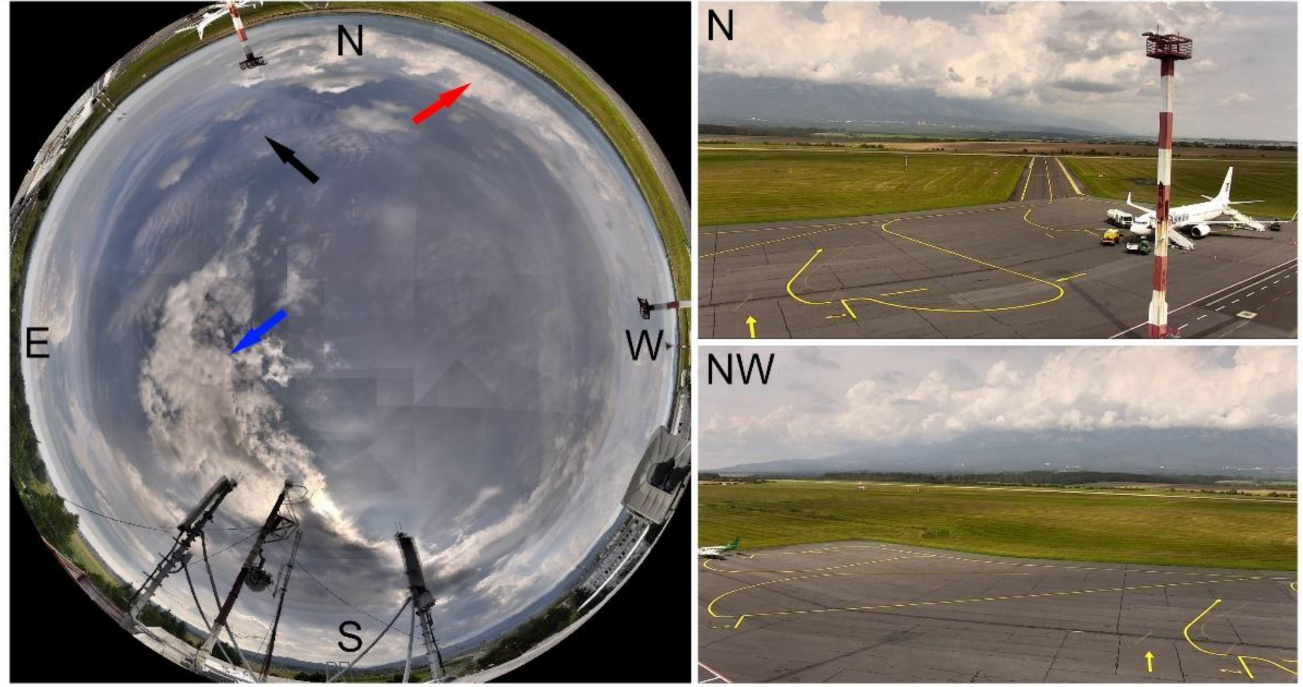
Figure 10. The same as Figure 9, but for 14 September 2018, at 09:50 UTC. Arrows denote different cloud types: red—towering cumulus, blue—altocumulus, and black—cirrus.